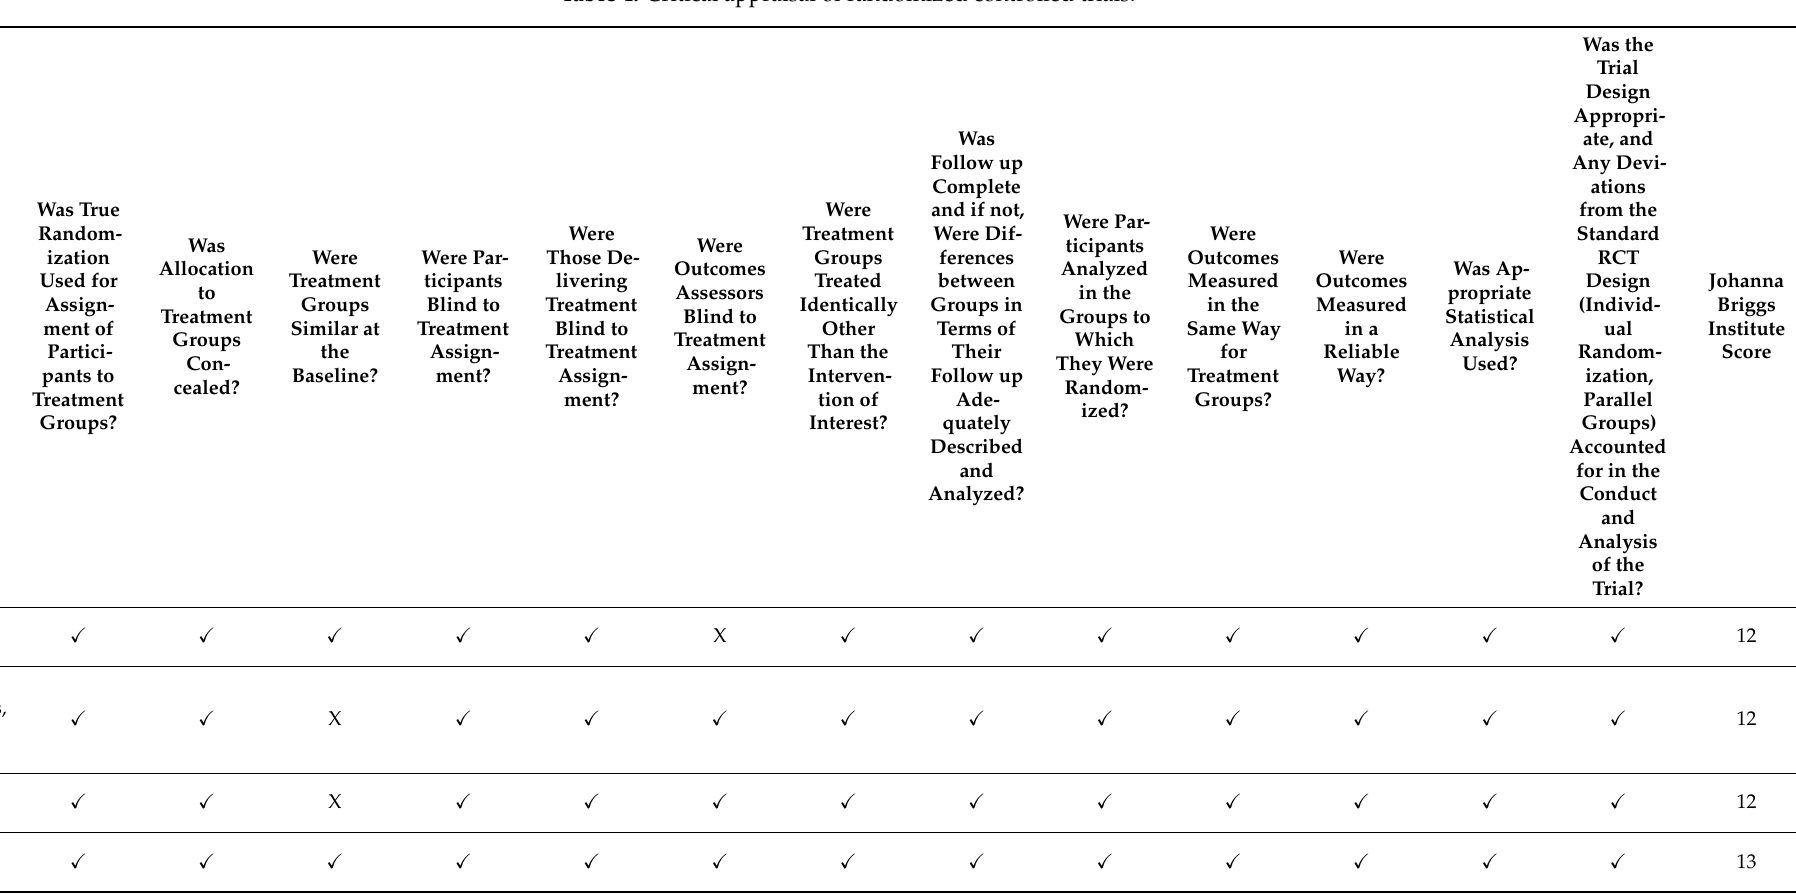
Table 4. Critical appraisal of randomized controlled